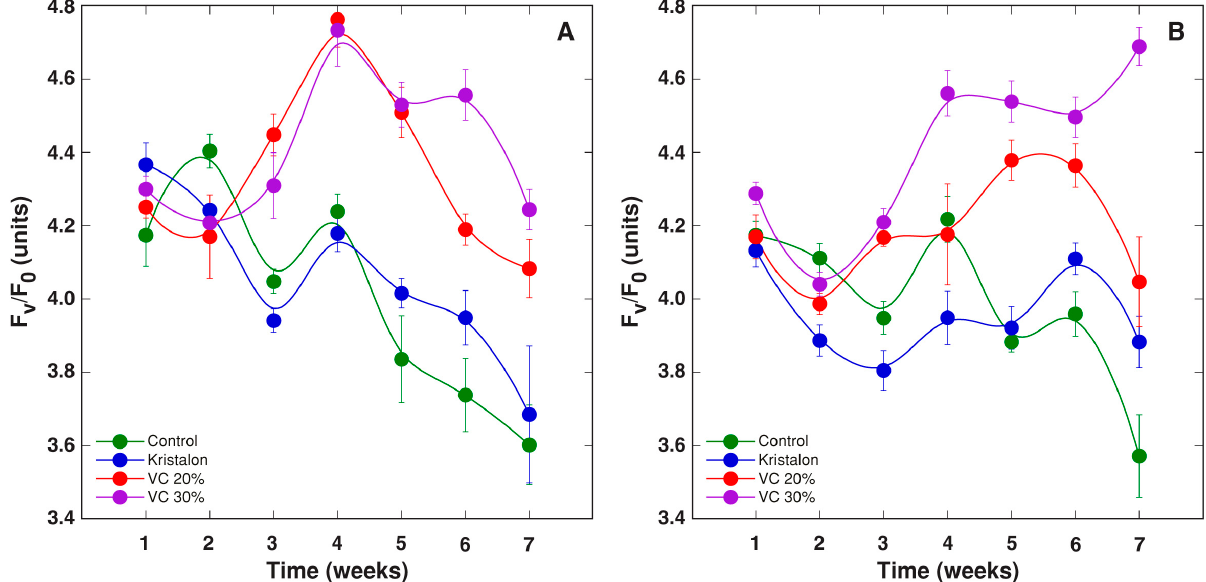
Figure 10. Changes of chlorophyll a fluorescence parameter F v /F 0 as affected by mineral fertilizer (Kristalon) and amendment with vermicompost (VC) at a 20% and 30% ( v / v ) rate in Dracocephalum moldavica plants grown in peat substrate ( A ) or commercial garden soil ( B ). Results are means ± SE from five replicates for each treatment, three measurements per replicate.